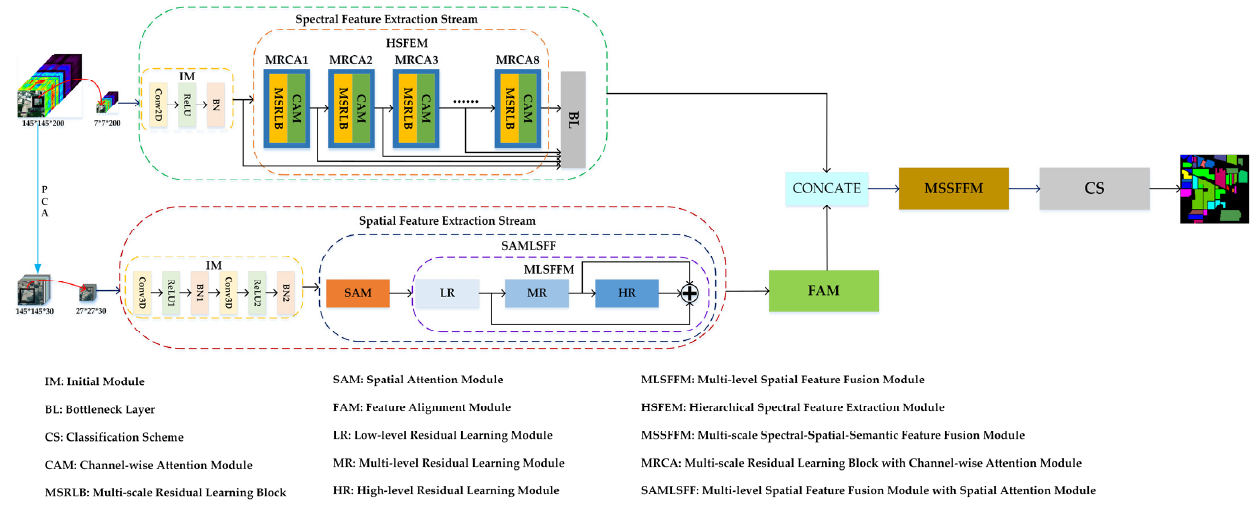
Figure 2. The overall framework of SMFFNet.